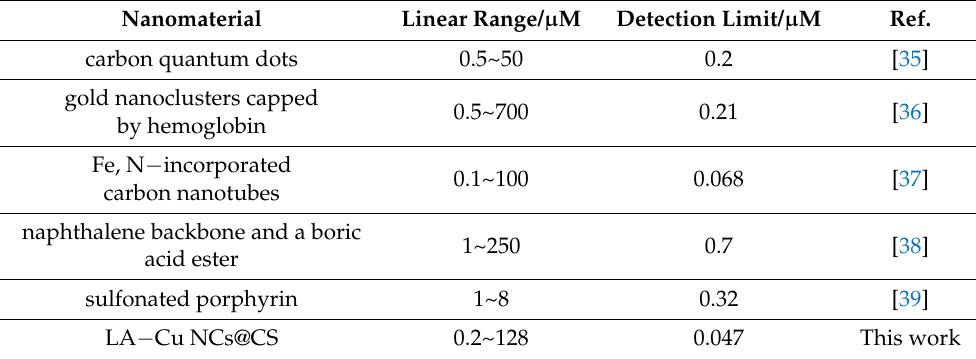
Figure 5. ( A ) The emission spectra of LA − Cu NCs@CS with increasing H 2 O 2 concentration ( B ) Linear relationship between H 2 O 2 concentration and LA − Cu NCs@CS FL quenching. Table 1. Comparison of different nanomaterials for H 2 O 2 detection.